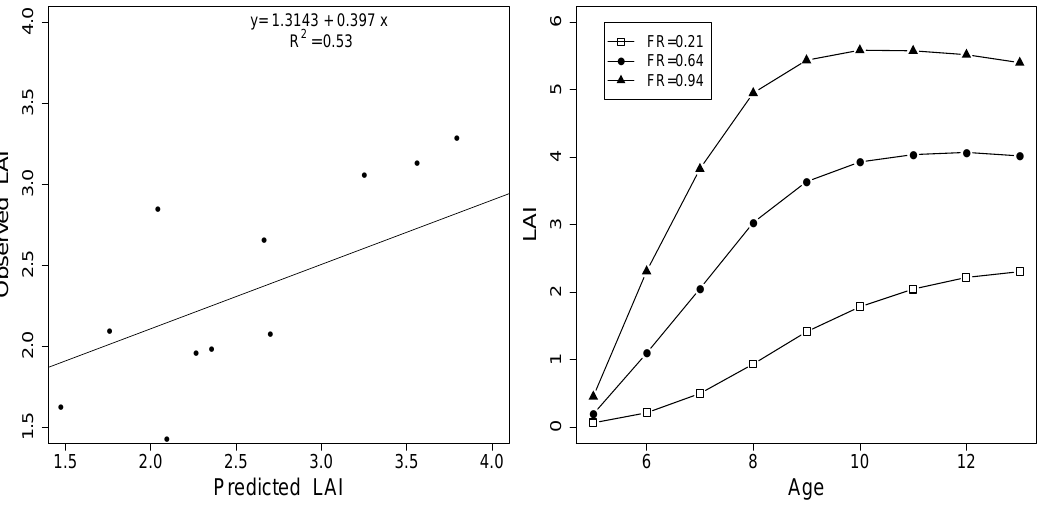
Figure 7. Relationship between measured LAI and 3-PG simulations from 3-PG across fertility gradients lob